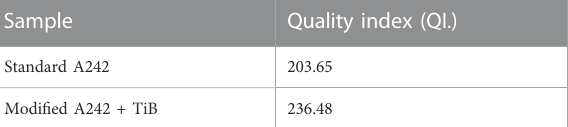
of 0.1% and its light atomic weight, as shown in Figure 1C, D. Figure 4 shows the EDS point for the formed phases in the standard and modi fi ed alloys. The EDS analysis con fi rms the presence of the metallic phases of Al 2 Cu, Mg 2 Si, Al 3 Ni, and Al 9 FeNi based on the α -Al solid solution in the reference alloy. These results are in agreement with (Rodríguez et al., 2012).